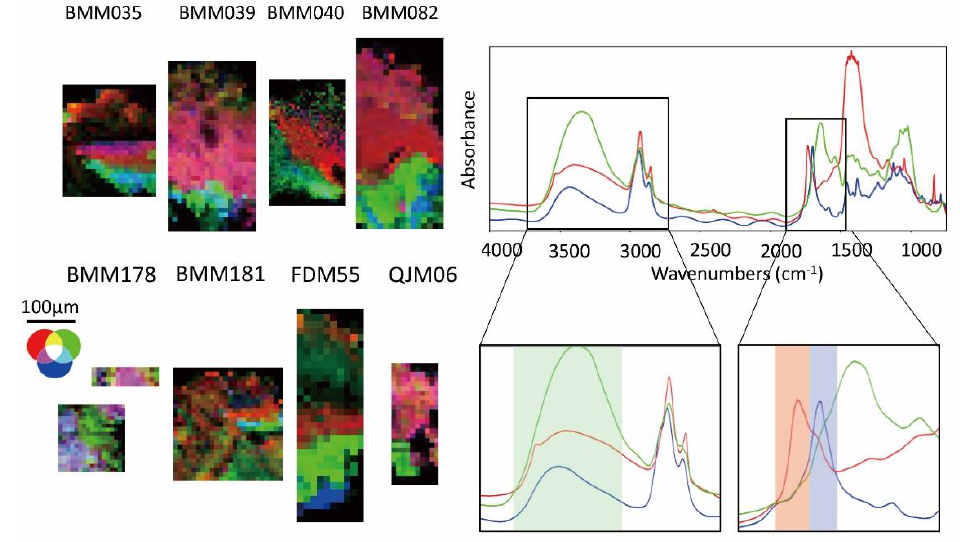
Figure 6. Left : µ FTIR maps based on regions of interest (ROI). Red: 1720–1747 cm − 1 ; green: 3131–3502 cm − 1 ; blue: 1681–1722 cm − 1 for the samples shown in Figure 5. Right : average FTIR spectra. extracted from the blue, green and red regions in the map of sample FDM55. Below: Close up of the CH ( left ) and CO ( right ) stretching regions. The coloured rectangles represent the ROI defined for the calculation of the maps. The red map highlights mainly oil ester groups. The green map highlights mainly proteins (amide A) but in the absence of proteins (BMM178 (Cave N(a)), a low signal from saponified oil and resin is visible. The blue map highlights mainly CO acid. With this specific ROI, natural resins are better seen, but oil (and in particular acidified oil) contributes as well (small shoulder in red spectrum).